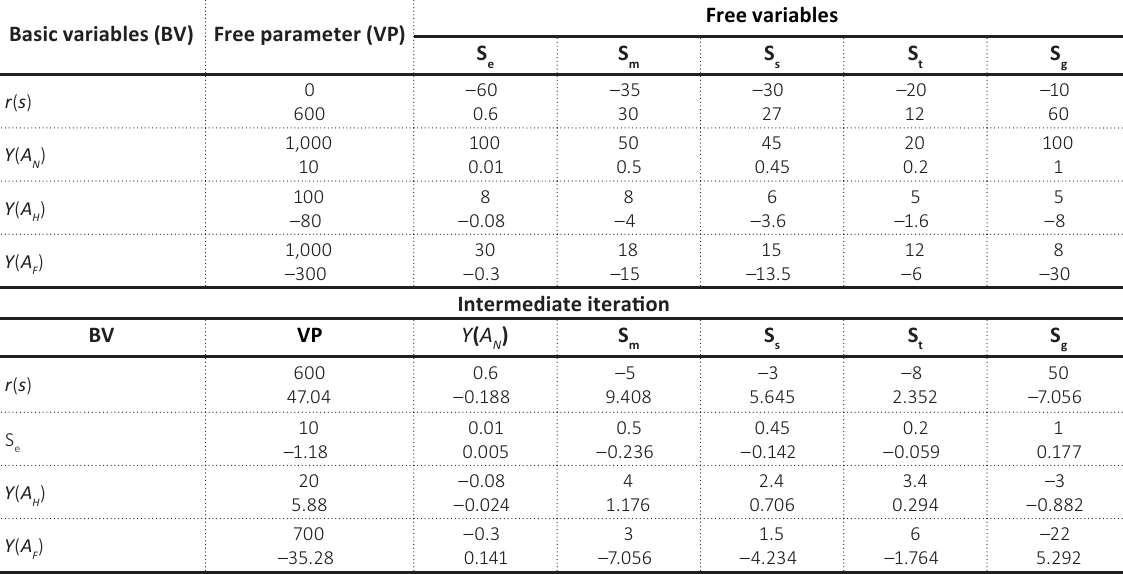
Table A2. Iterations of linear programming (destination of nature-based tourism specializing in services of “wow-effect”